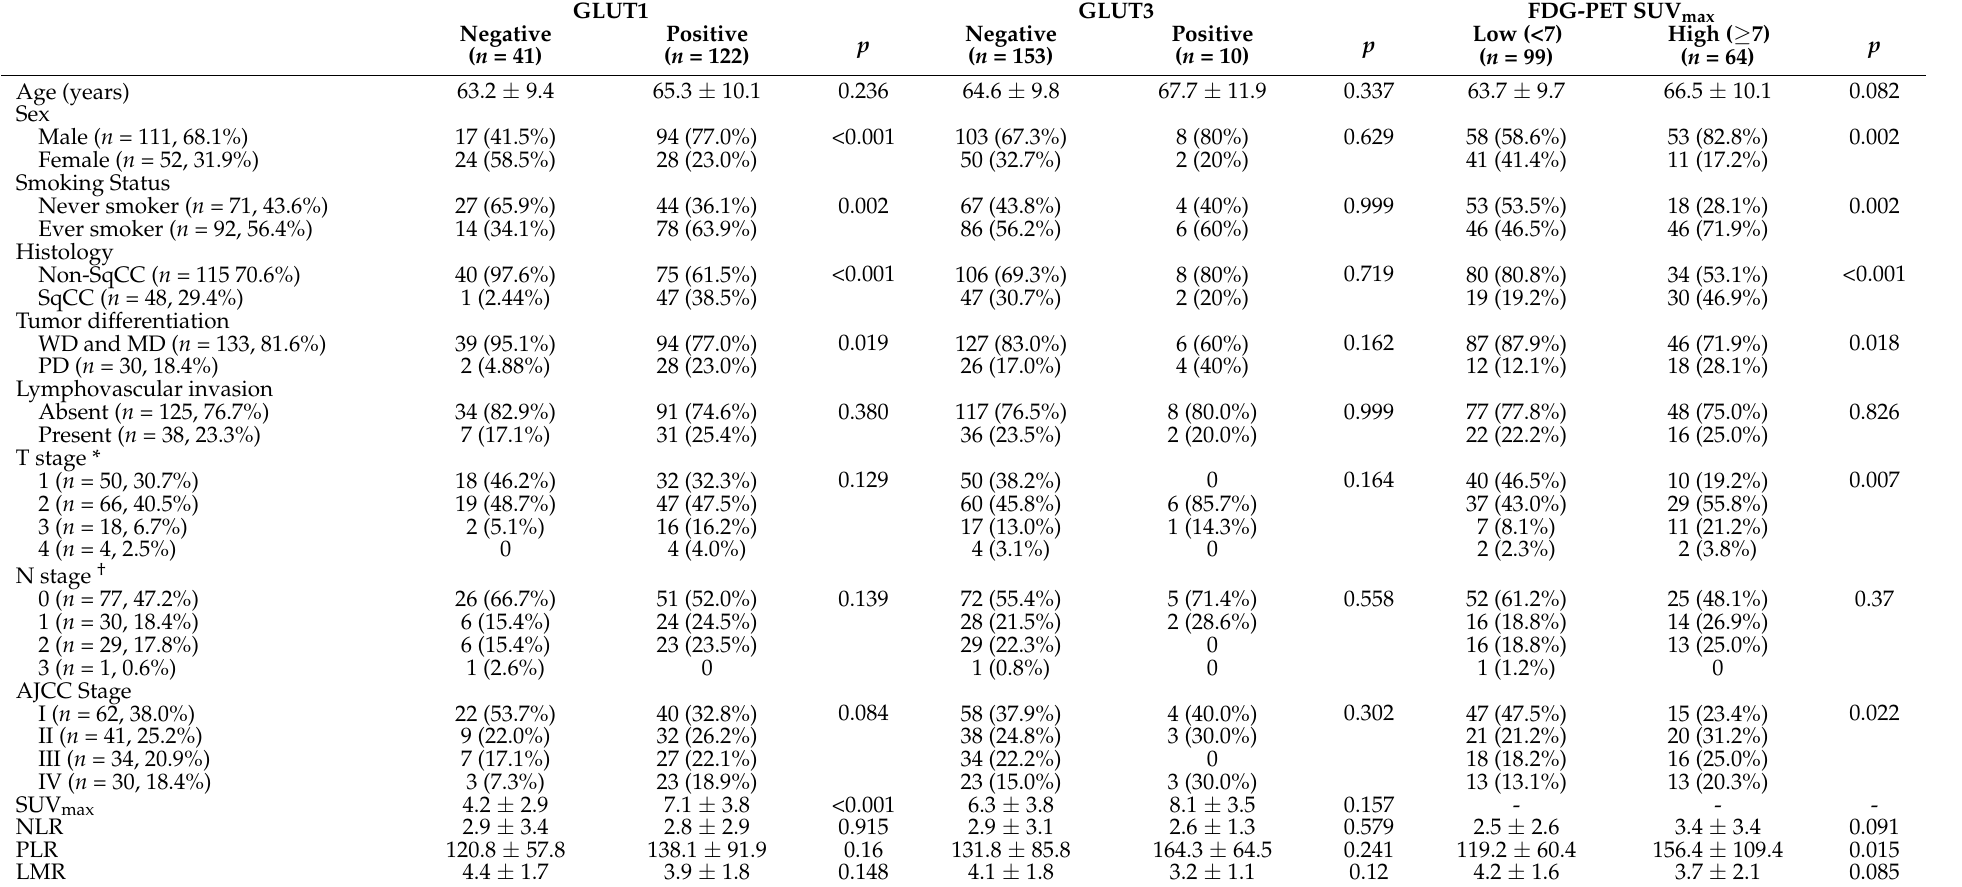
Table 1. Relationship between metabolic markers and clinicopathologic features in patients with non-small cell lung